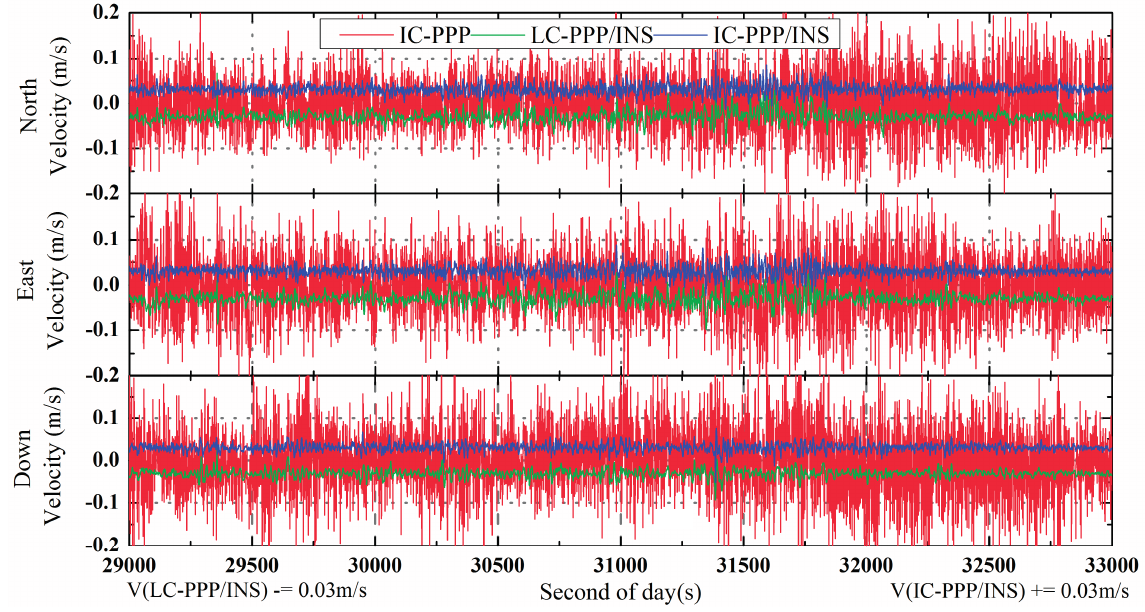
Figure 4. Velocity differences of IC-PPP ( red line), LC-PPP/INS ( green line), and IC-PPP/INS ( blue line) with respect to the reference solutions; LC-PPP/INS and IC-PPP/INS velocities are shifted by − 0.03 m/s and +0.03 m/s, respectively, for